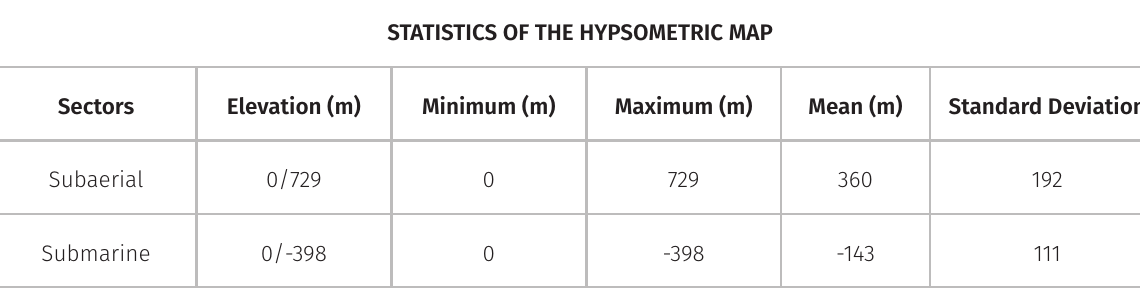
Table II. Hypsometric statistics for submarine and subaerial sectors in Martel Inlet. STATISTICS OF THE HYPSOMETRIC